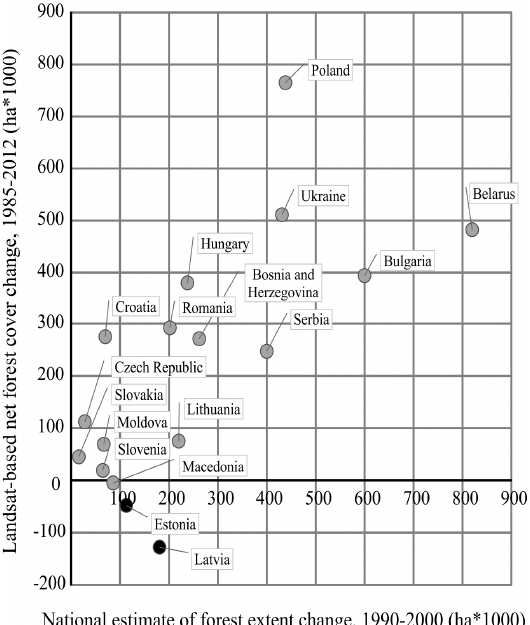
Figure 5. Inter-comparison between Landsat-based and official (Forest Europe., 2011) net forest cover change estimates